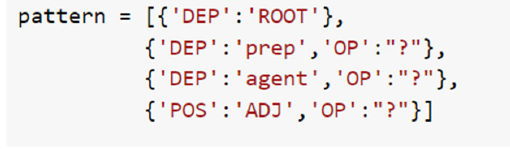
Figure 12. Pattern Added to the Matcher.